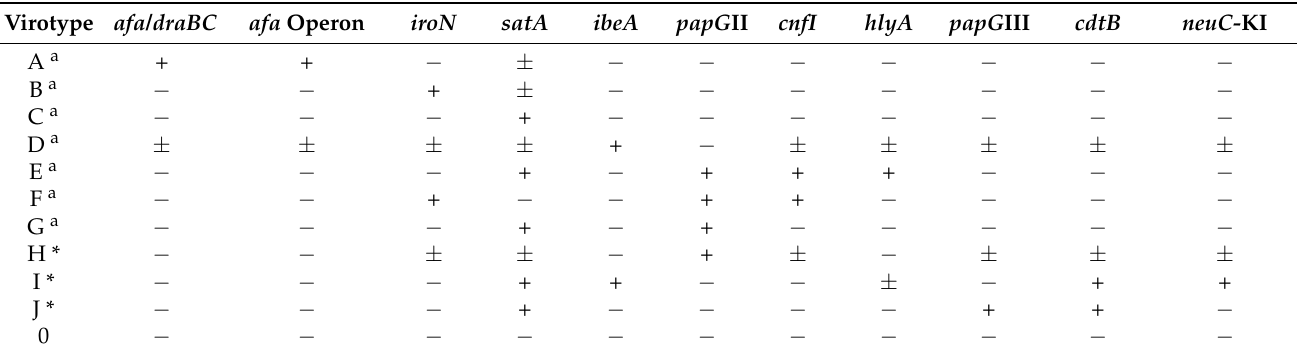
Table 2. Virulence coding genes present in E. coli strains isolated from healthy donors from H. Caborca,